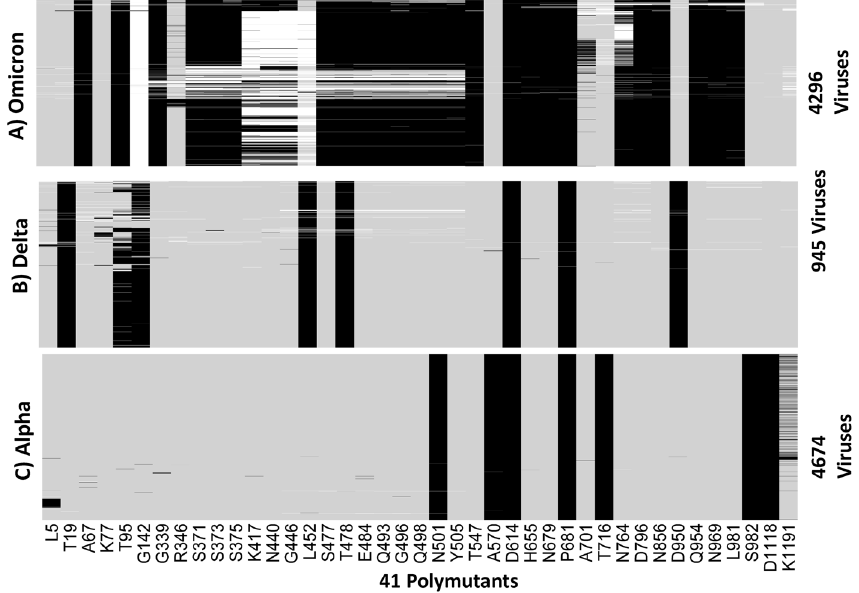
Figure 2. Profiles of 41 polymutants in spike protein (> 5% mutation percentages) in ( A ) Omicron, ( B ) Delta and ( C ) Alpha. Each mutation is represented by a black line, wildtype by a gray line, and missing data by a white line. Heatmaps are generated by the heatmap package in statistical R software 3